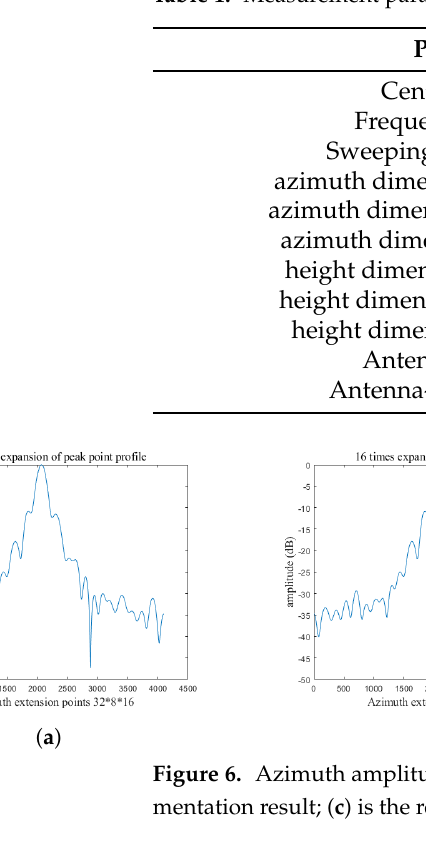
Table 1. Measurement parameters used in the simulation and the experiment.